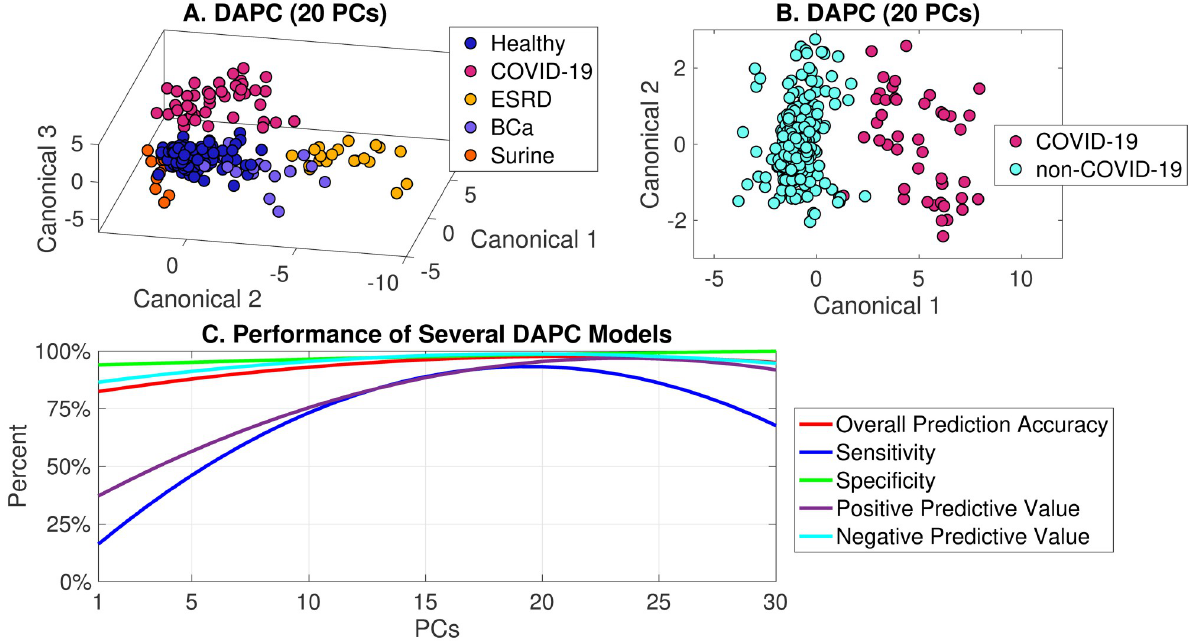
Fig 3. DAPC models demonstrating cluster separation of COVID-19 Raman urine spectra from those of other groups (A, B), and DAPC predictive model performance (C).